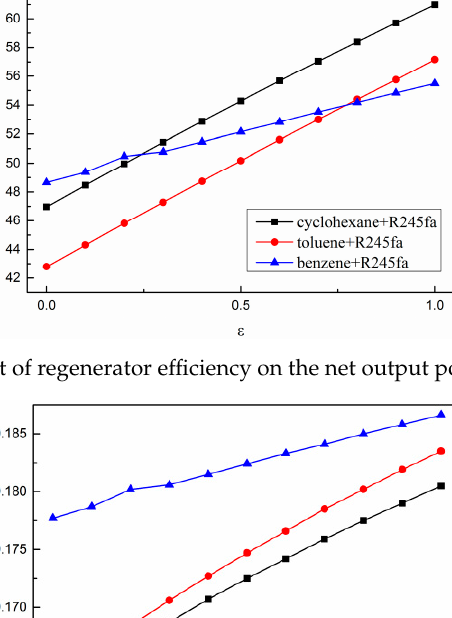
Figure 5. Effect of regenerator efficiency on the primary heat exchange outlet temperature of exhaust gas.